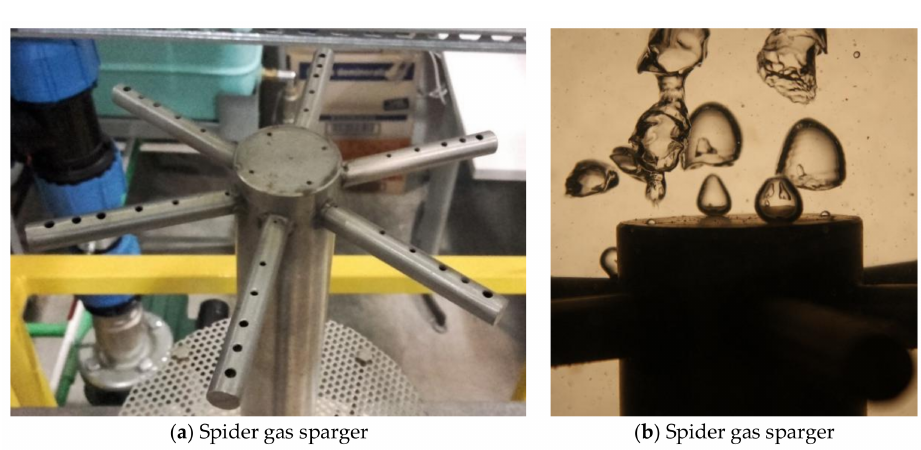
Figure 5. “Fine gas sparger”.